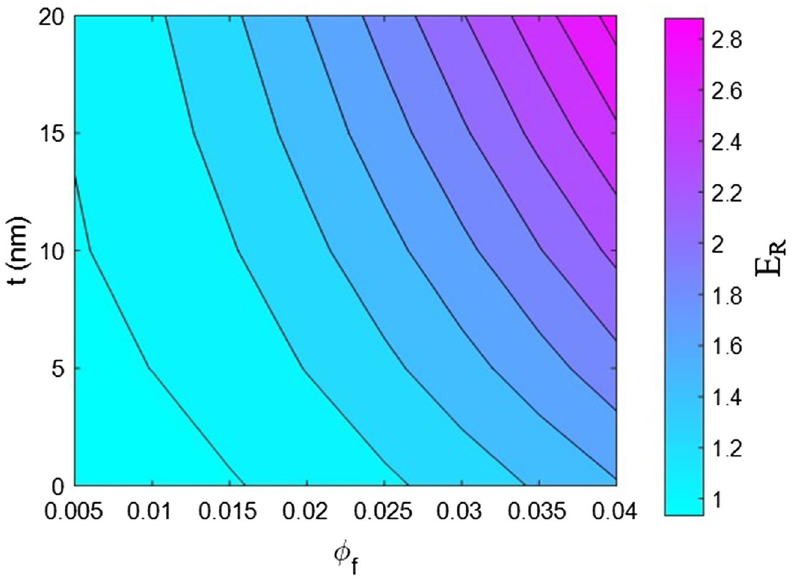
Figure 3. Dependences of “E R ” on HNT concentration and interphase depth as estimated using the proposed